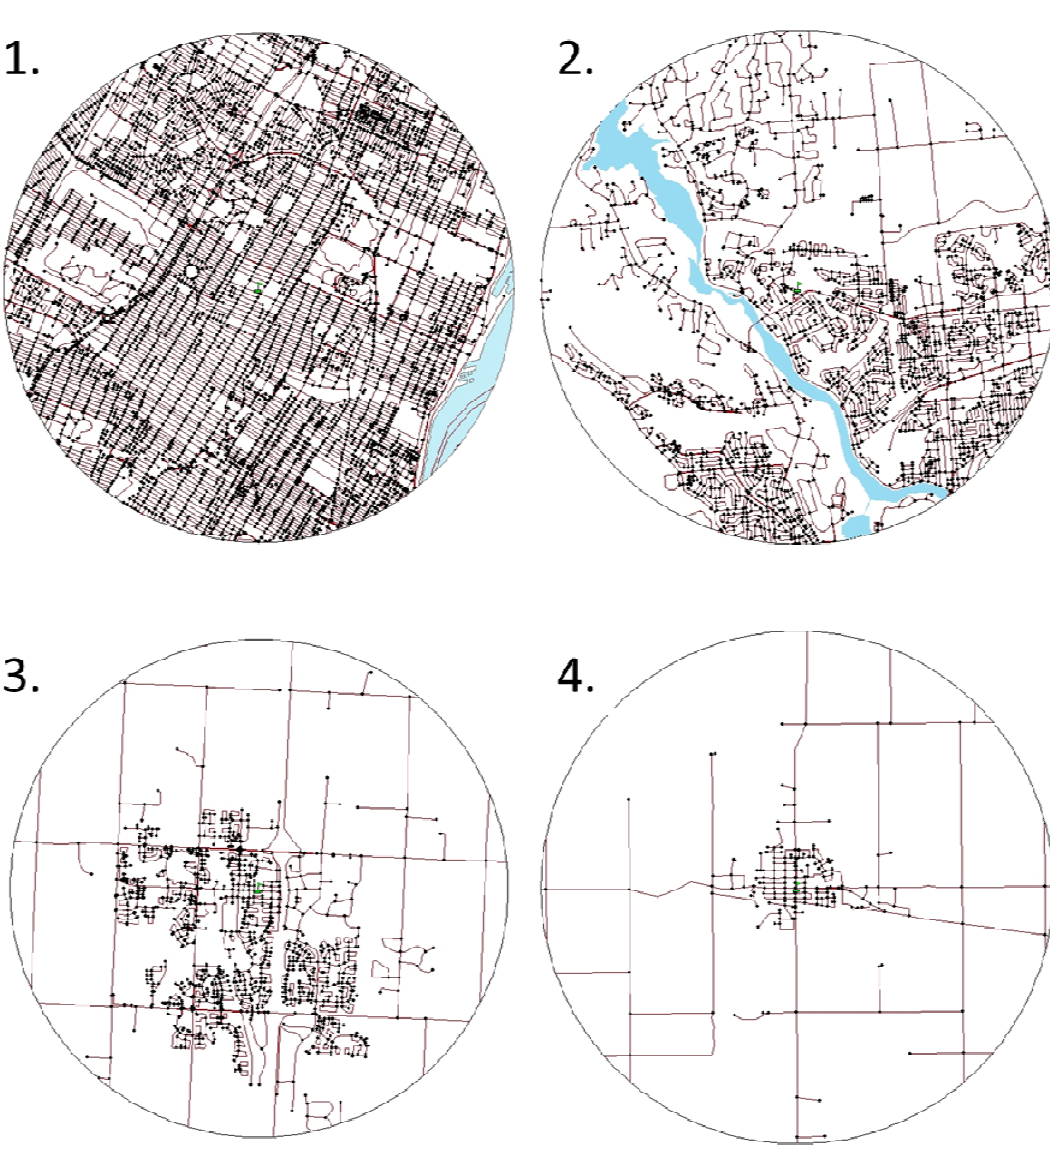
Figure 2. Example neighbourhoods from the different street connectivity